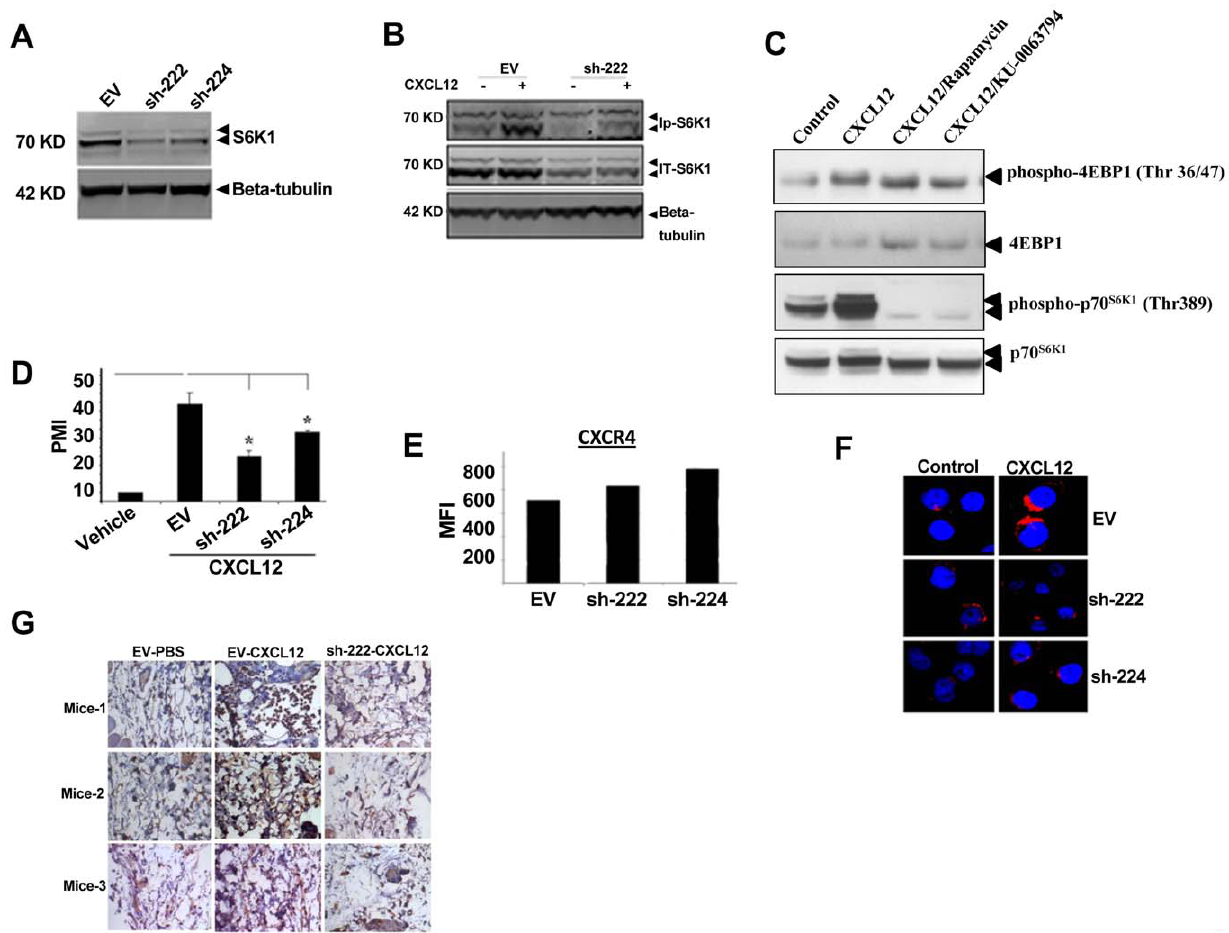
Figure 2. Role of mTOR in CXCL12-induced signaling and cell migration. (A) Whole cell lysates from CEM stable clones carrying either empty vector (EV) or shRNA constructs (sh-222 and sh-224) were analyzed by western blot analysis to determine the levels of total p70 S6K1 . (B) Whole cell lysates from EV and sh-222 clones treated with CXCL12 for 30 minutes were analyzed by western blot analysis to determine the levels of phospho- p70 S6K1 . (C) CEM cells were pretreated with rapamycin (100 ng/ml) and KU-0063794 (1 m M) for 1 hour, and then CXCL12 treatment was done for 30 minutes. Equal amounts of whole cell lysates were analyzed by western blot analysis. (D) Migration assay for EV, sh-222 and sh-224 clones were performed similarly as primary T cells described in Fig. 1A. (E) Surface expression of CXCR4 for EV, sh-222, and sh-224 were determined by FACS analysis, and the levels are expressed as mean fluorescence intensity (MFI). (F) Confocal microscopy to monitor CXCL12-induced actin polymerization in EV, sh-222, and sh-224 clones were performed similarly as primary T cells described in Fig. 1B. (G) In vivo migration of EV and sh-222 clone mediated by CXCL12 was determined as described in Materials and Methods. Tissue staining from individual mice is shown here.